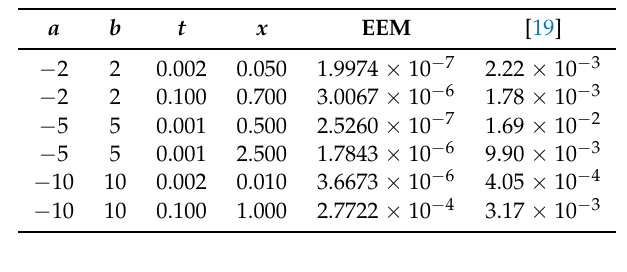
Table 6. Comparisons between the results obtained by the LMM with those adapted from [19] in term of L abs error norm for Test Problem